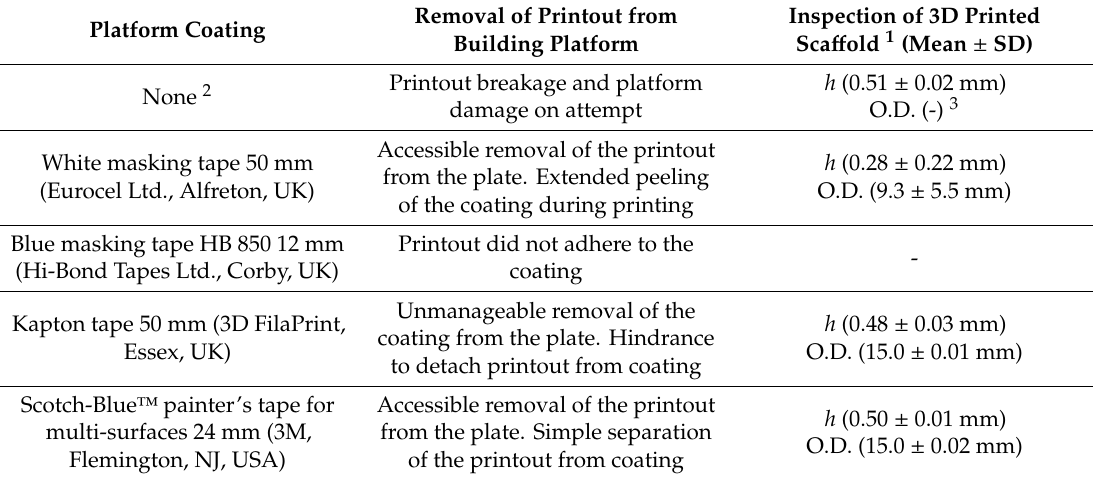
Table 1. Building platform coatings used during the 3D printing